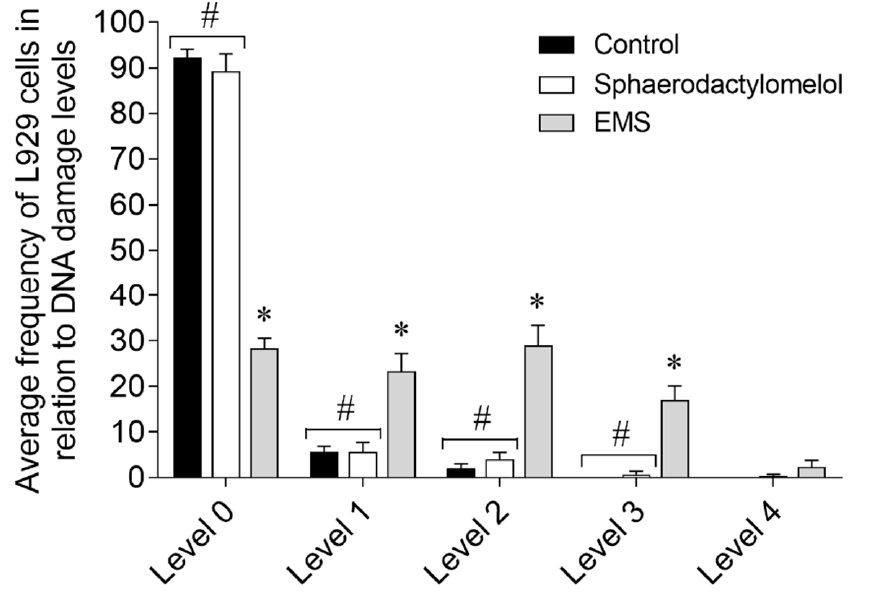
Figure 5. Frequency of L929 fibroblasts DNA change following exposure to sphaerodactylomelol (48 µ M) and ethyl methanesulfonate (EMS) for 3 h. Values represent the mean ± SEM of three independent experiments. Damage index: Σ (comet class: 1, 2, 3, 4). 0, nucleus without DNA damage. Symbols represent significant differences ( p < 0.05) when compared to: * control; # EMS.